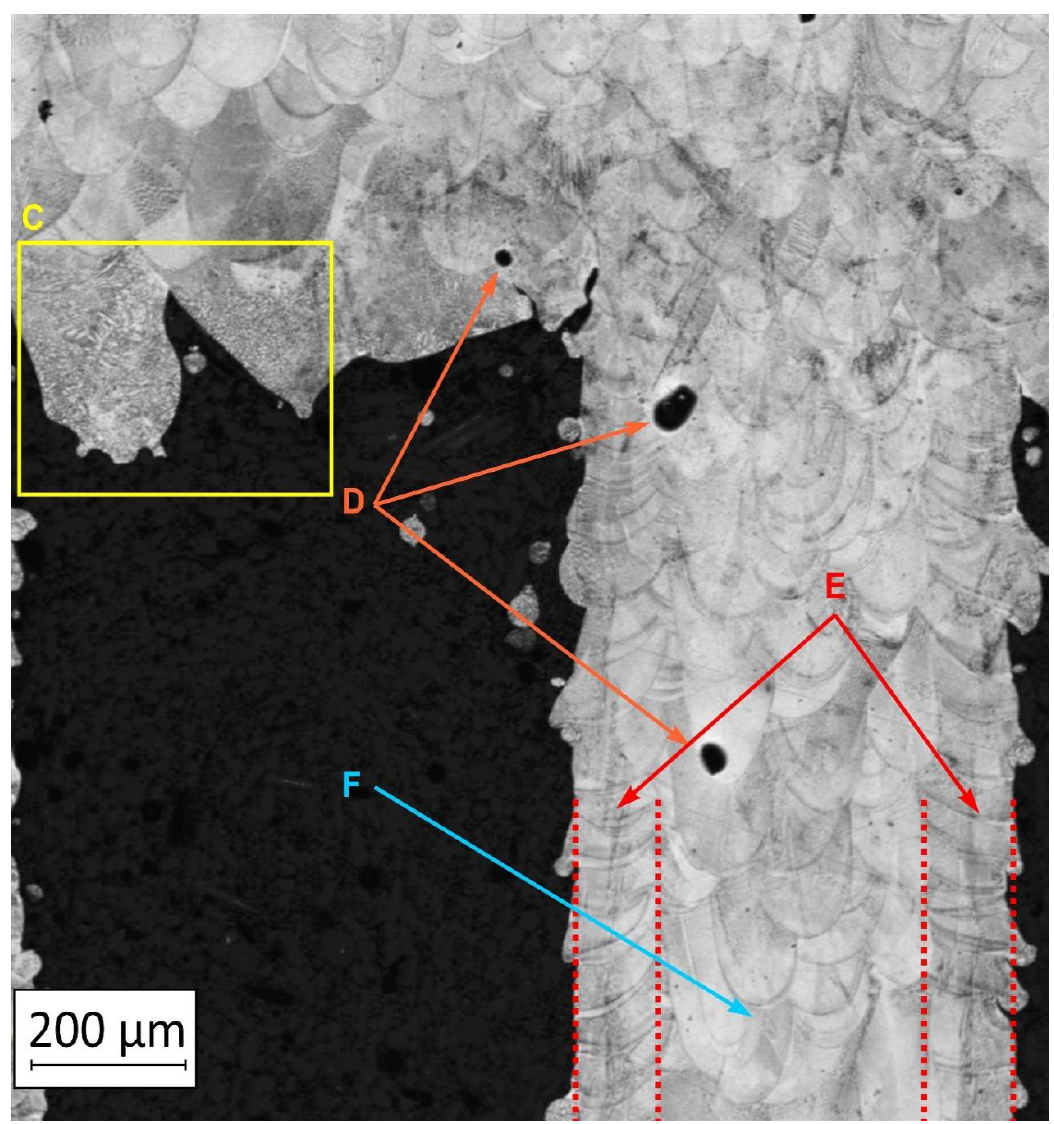
Figure 4. The microstructure of the manufactured sample in the area showing a connection of the thin-walled and monolithic parts with the following elements marked: bridge ( C ), porosity ( D ),the laser-exposure outline shell ( E ), and the laser-exposure core of the part ( F